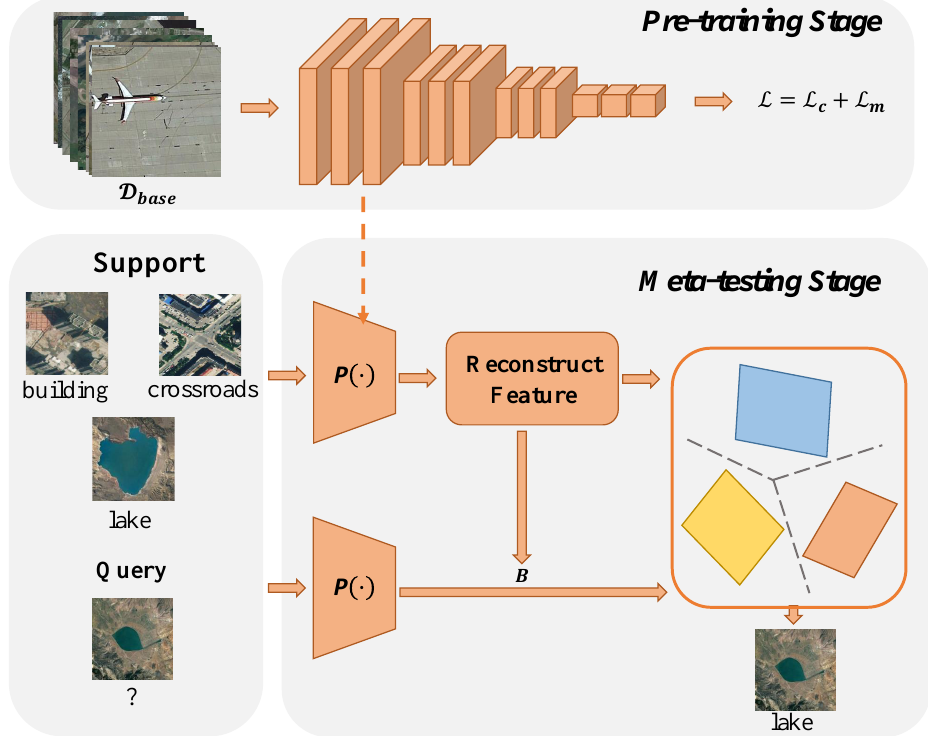
Figure 1. The framework of